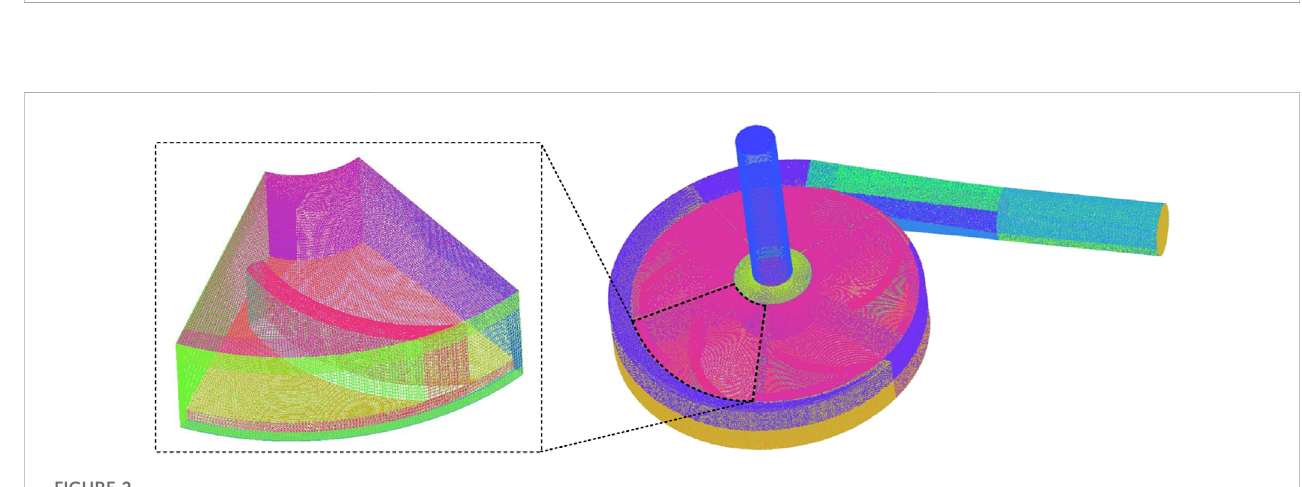
Structure and photo of the rotary blood pump. (A) Structure of the blood pump; (B) top-view photo of the blood